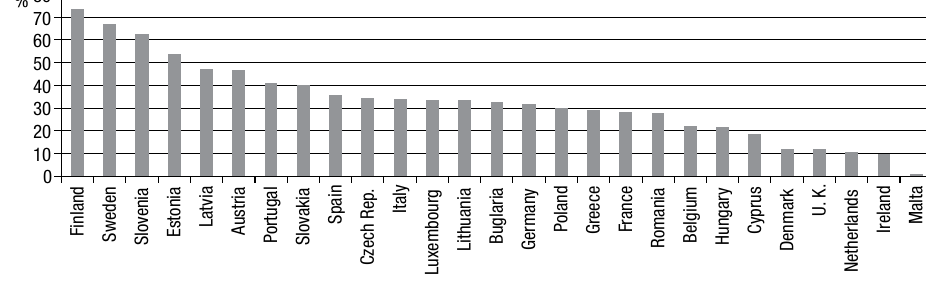
Fig. 2. Forest cover in the EU Member States as a percentage of the total land areas Source : Global Forest …